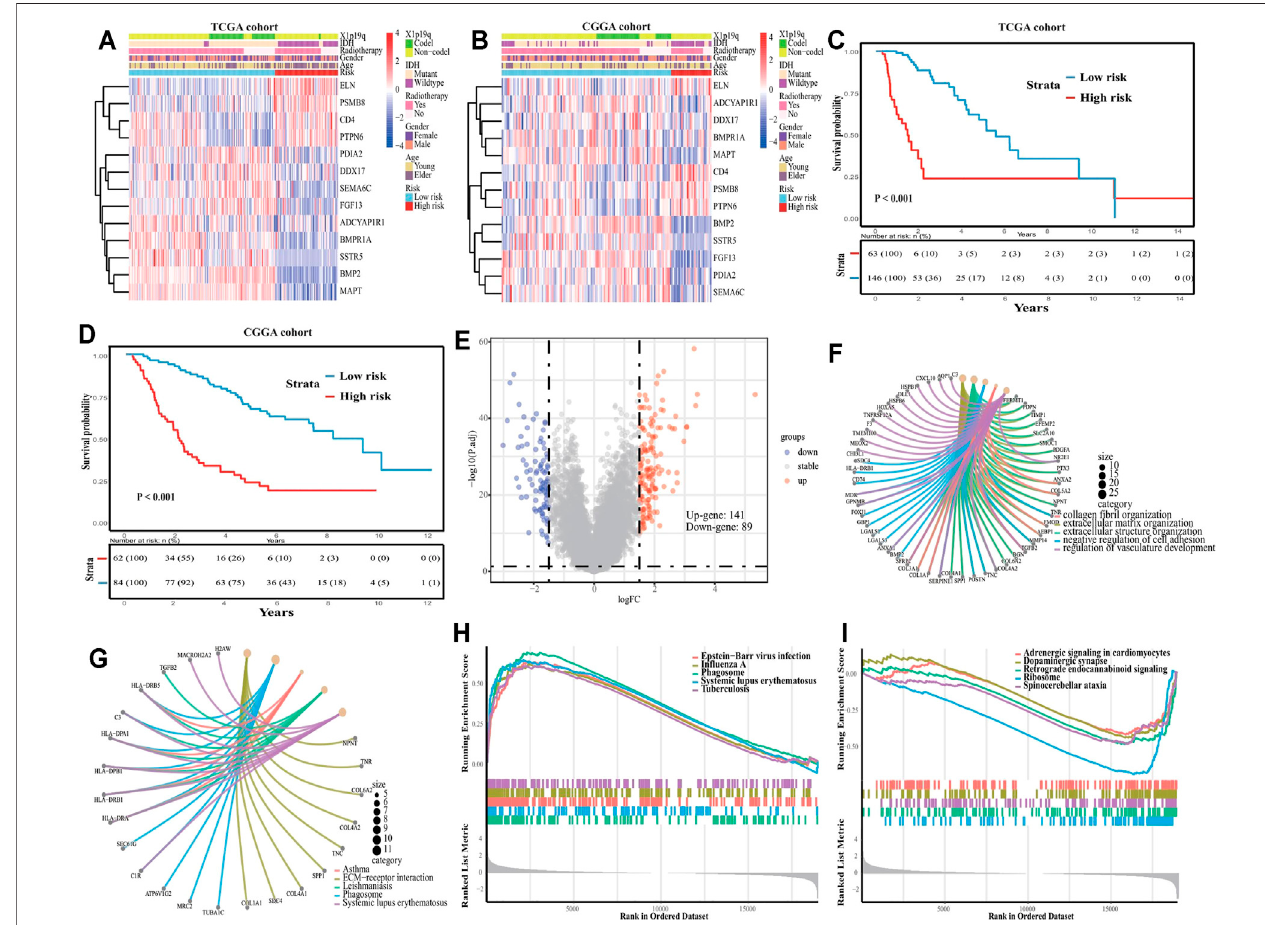
FIGURE 8 | Subclass analysis for tumor grade III. (A) Gene expression pro fi le in TCGA cohort, and (B) in CGGA cohort. (C) Kaplan-Meier curve for TCGA cohort patients, and (D) for CGGA cohort patients. (E) Volcano plot between high- and low-risk groups. (F) GO enrichment for differential genes . (G) KEGG enrichment for differential genes . (H) GSEA in the high-risk score, and (I) in low-risk score.